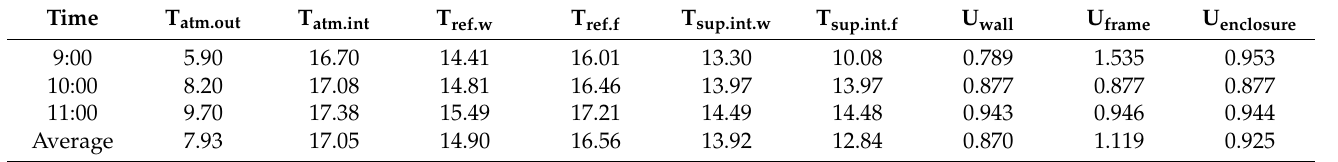
Table 5. Input values and results for the calculation of exterior enclosure U value of Room